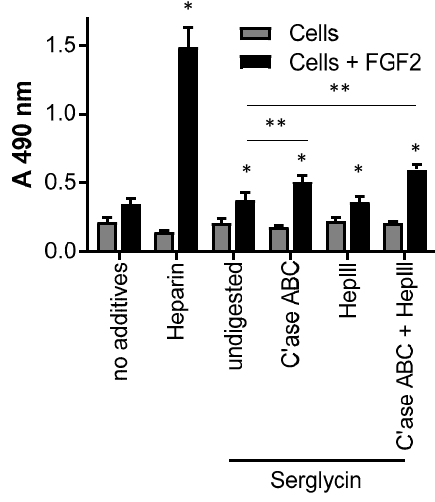
Figure 7. Activity of serglycin with heparin/heparan sulfate and chondroitin sulfate chains determined by the signaling of FGF receptor type 1c expressing BaF32 cells in the presence of FGF-2 as mesured by the MTS assay. Cells in the presence of FGF-2 and heparin were used as a control for the formation of active ternary complexes. Negative controls were cells in the presence of no additives, heparin, or FGF-2. Selected serglycin preparations were digested with either chondroitinase ABC, hepIII or both glycosaminoglycan lysases prior to the assay. Cell proliferation was measured after 72 h. * indicated significant differences ( p < 0.05) within treatments for cells and FGF-2 compared to cells only as determined by a one-way ANOVA; ** indicated significant differences ( p < 0.05) as determined by two-way